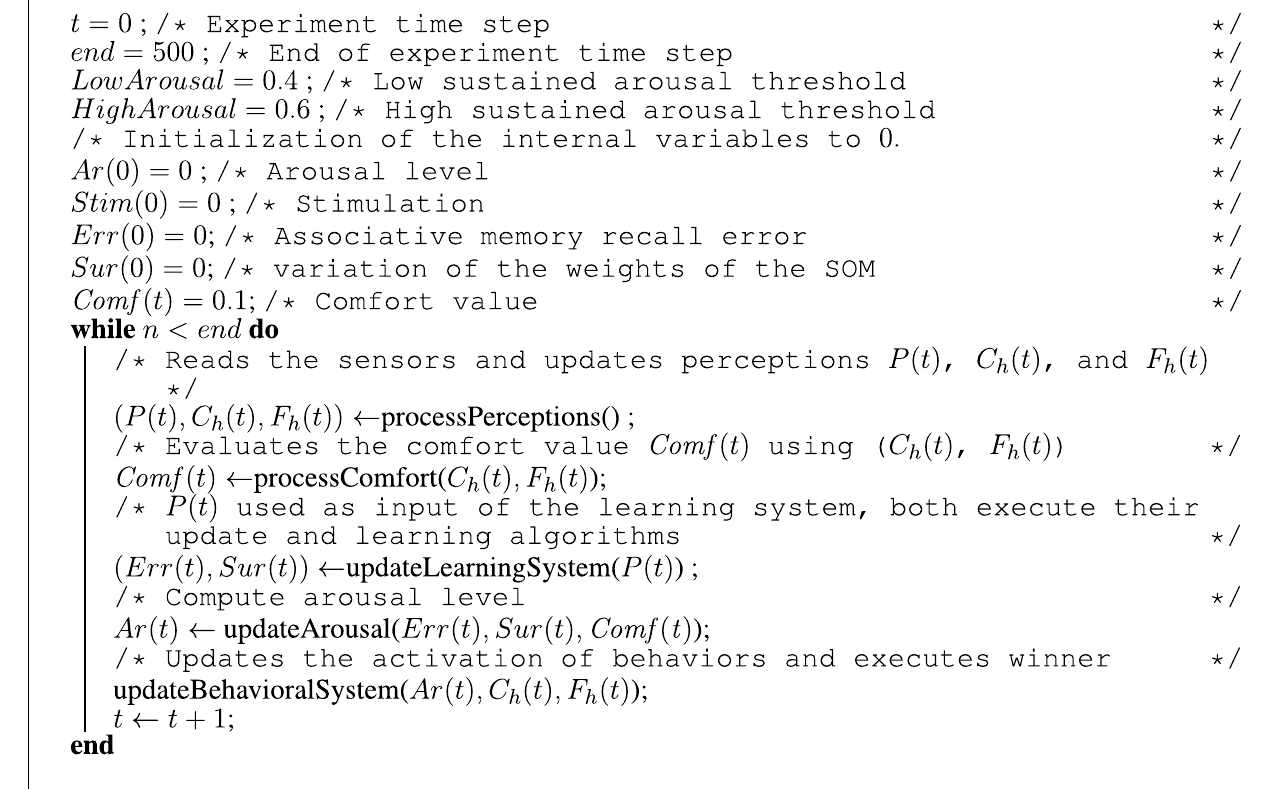
Algorithm 1 | Algorithm for the entire architecture.